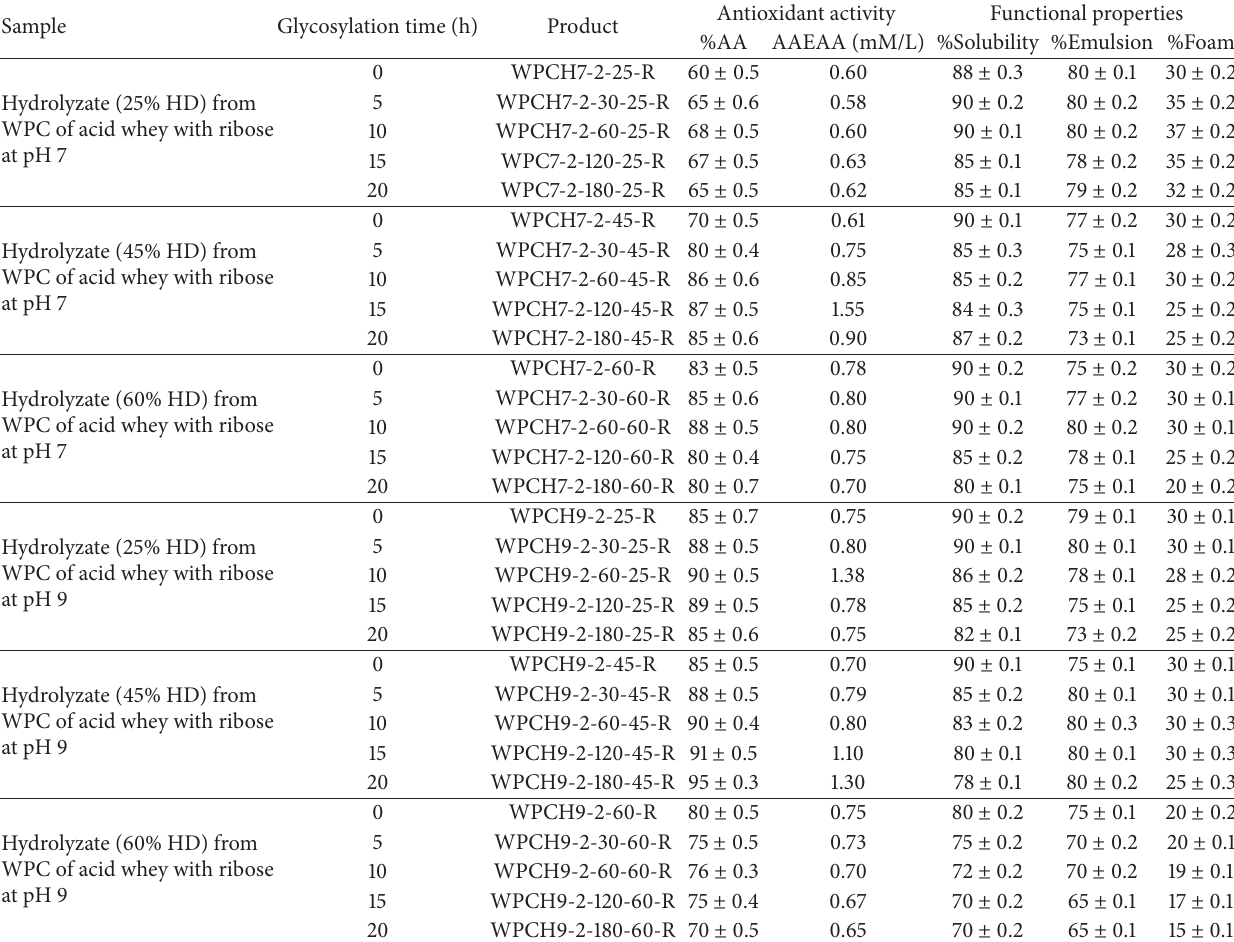
Table 6: Features of glycosylated product from hydrolyzates from WPC of acid whey with ribose, heating to 50 ∘ C, pH 7 and pH 9.